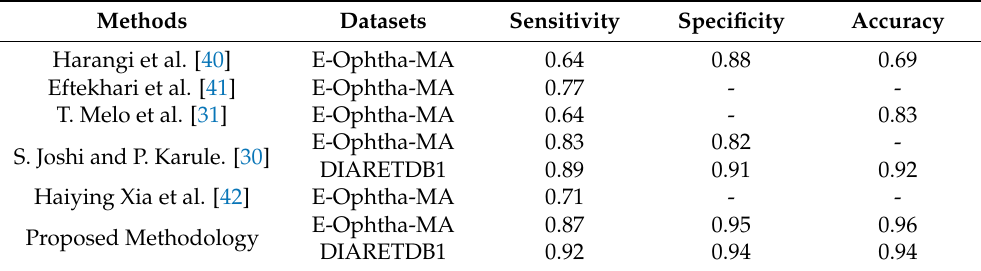
Table 3. Overall microaneurysms classification performance of the proposed approach against literature